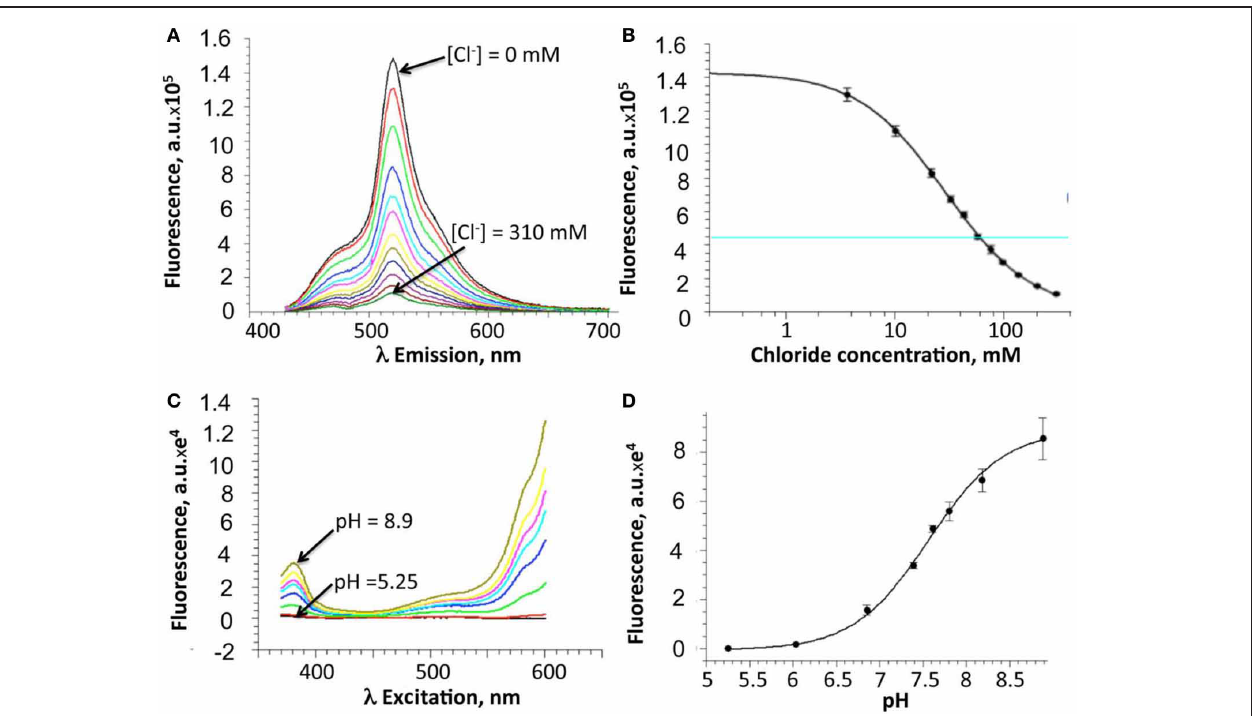
FIGURE 2 | In vitro properties of the H148G/V224L ClopHensor mutant. (A) Emission spectra at pH 7.0 for excitation at 415nm, at increasing Cl − concentrations from 0mM ( top spectrum ) to 310mM ( bottom spectrum ). Note the reduction in fluorescence intensity due to Cl − binding-site quenching. (B) Dependence on Cl − concentration of the fluorescence